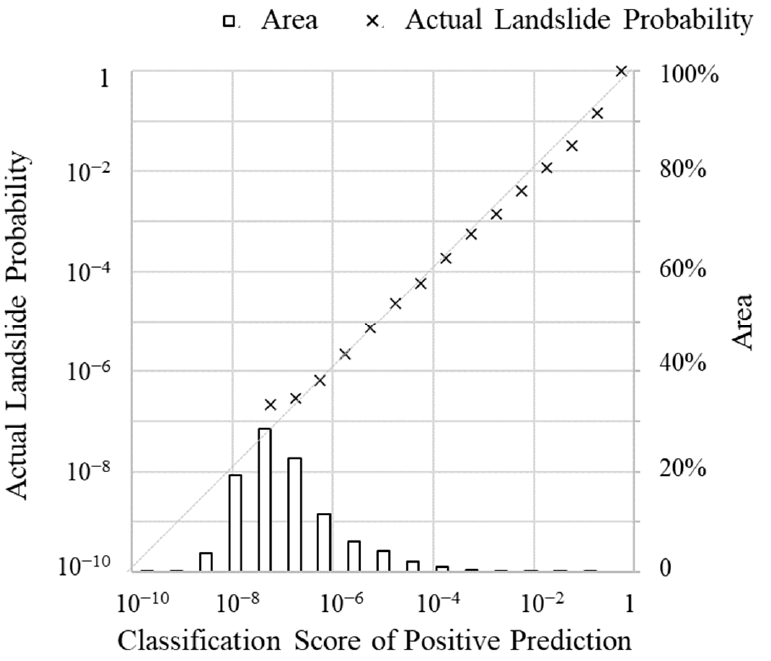
Figure 13. Actual Landslide Probability by Positive Classification Scores (FS2-24-XGB).